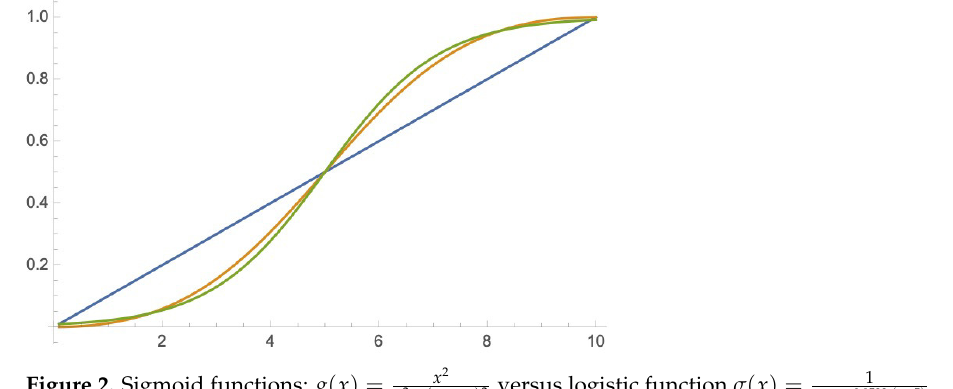
versus logistic function σ ( x ) = 1 x 2 +( 10 − x ) 2